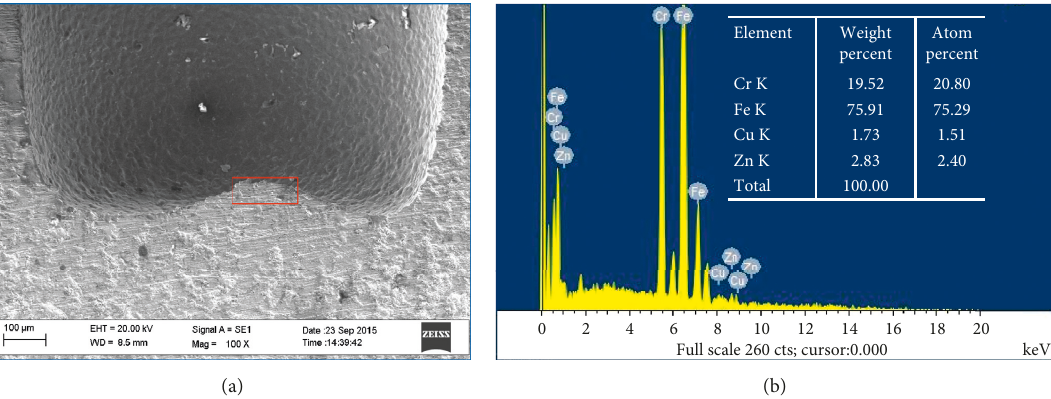
Figure 17: EDS spectral analyses of the hole cross section. (a) SEM. (b)